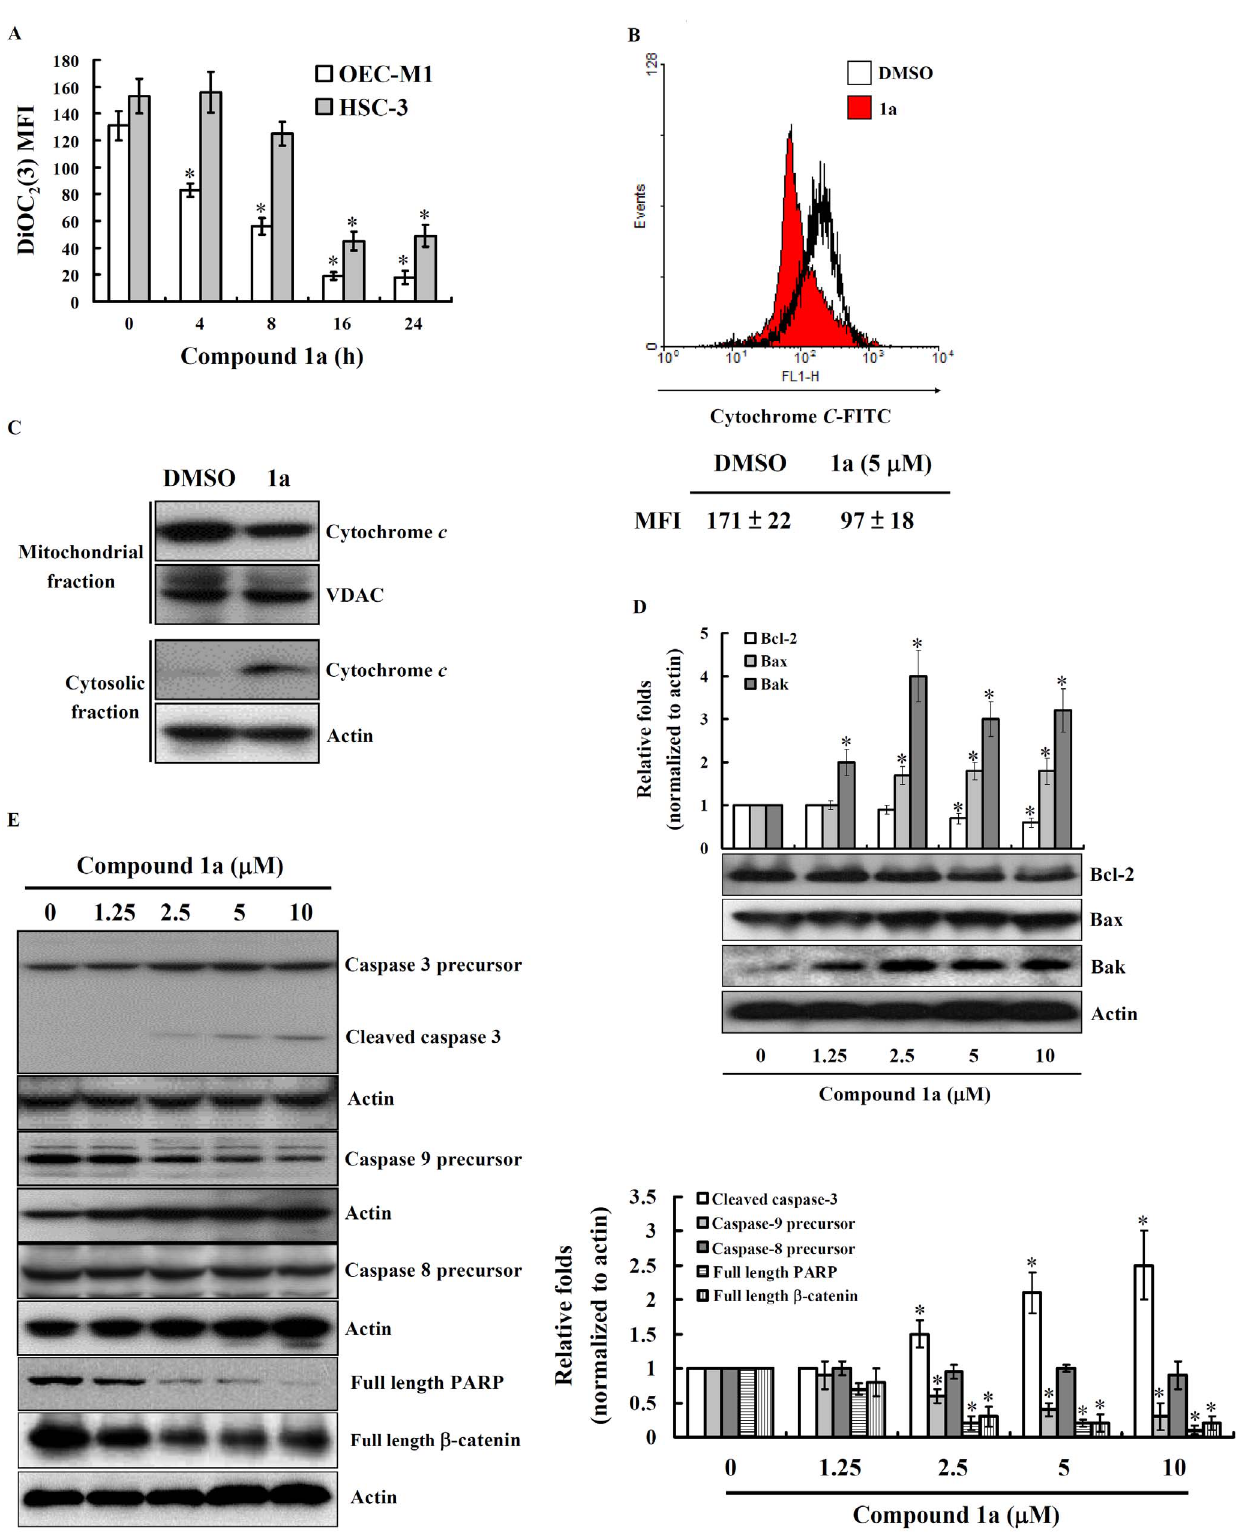
Figure 3. Compound 1a induces mitochondrial death pathway and caspase-dependent apoptosis. ( A ) Cells were stimulated with compound 1a (5 m M) or vehicle (0.1% DMSO) for the time indicated, followed by DiOC 2 (3) staining. The mitochondrial membrane potential was analyzed by flow cytometry. The results were expressed as mean 6 SD of mean fluorescence intensity (MFI); n=3. ( B ) OEC-M1 cells were stimulated with compound 1a (5 m M) or vehicle for 16 h, the cytochrome c in mitochondria was measured by flow cytometry. The results were expressed as mean 6 SD of MFI; n=3. ( C ) The cytochrome c in mitochondrial fraction and cytosolic fraction were measured by western blotting. Voltage- dependent anion channel (VDAC) and actin were used as a marker protein for mitochondria and cytosol respectively. One of three repeated